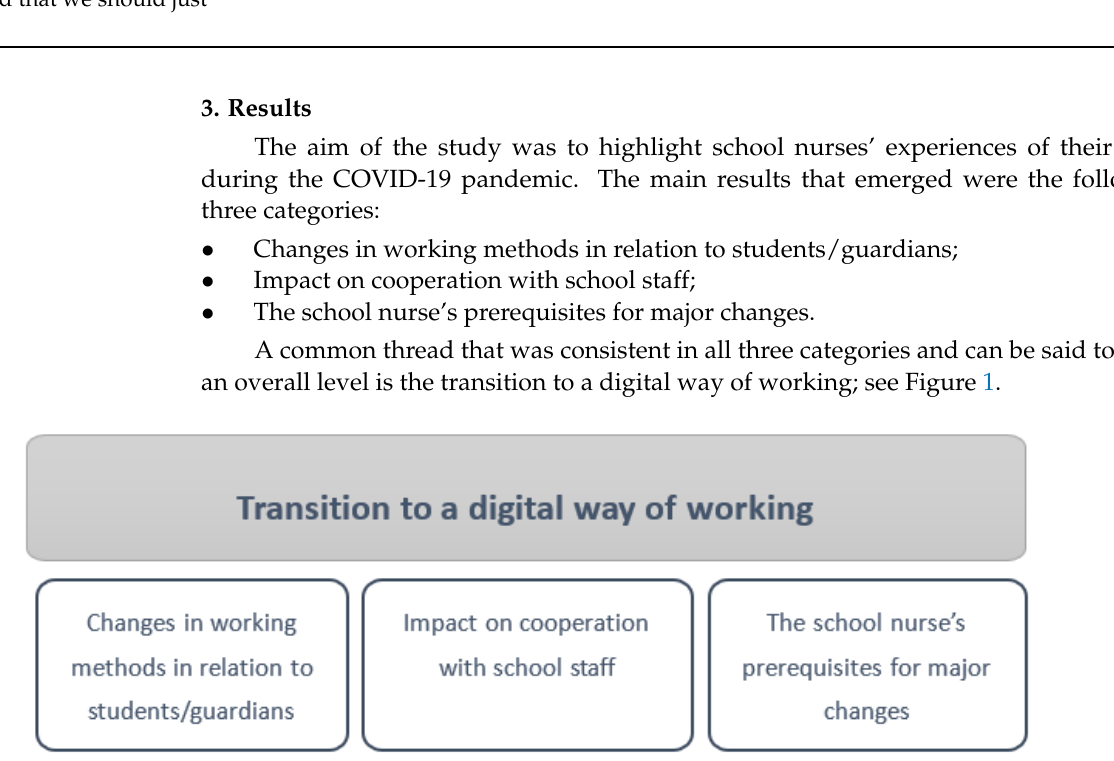
Figure 1. A common thread, “Transition to a digital way of working,” and three categories: Changes in working methods in relation to students/guardians, Impact on cooperation with school staff, and School nurses’ prerequisites for major changes.